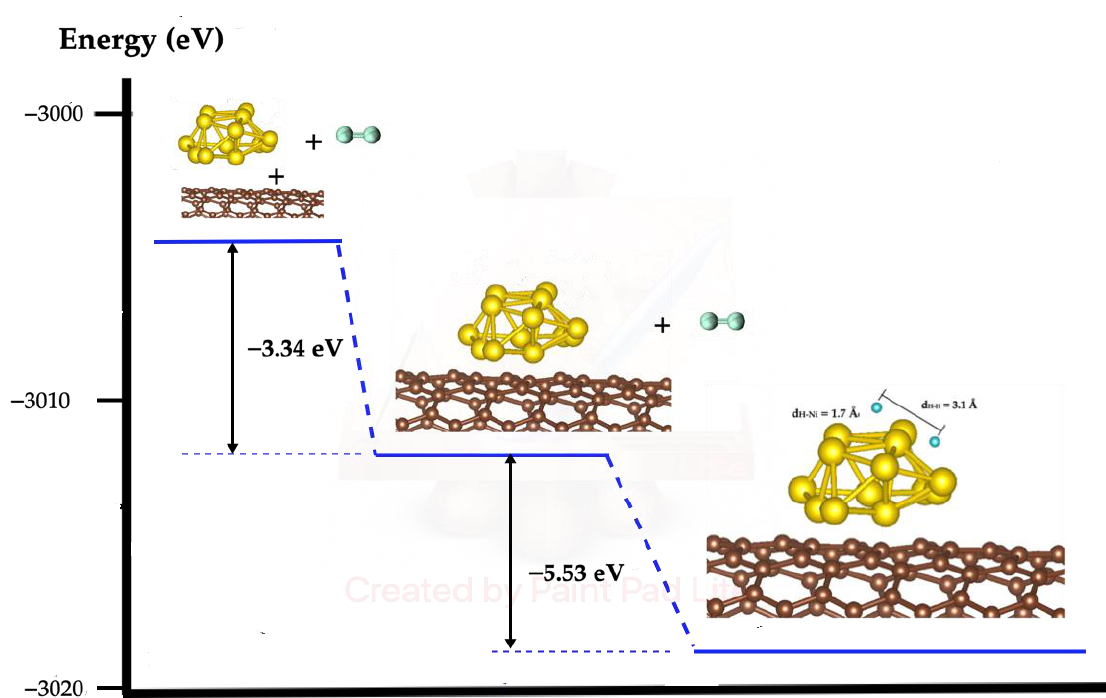
Figure 5. H 2 dissociation on Ni 13 metallic cluster adsorbed on SWCN. The yellow spheres indicate Ni atoms, brown spheres represent C atoms and small blue spheres are H atoms.